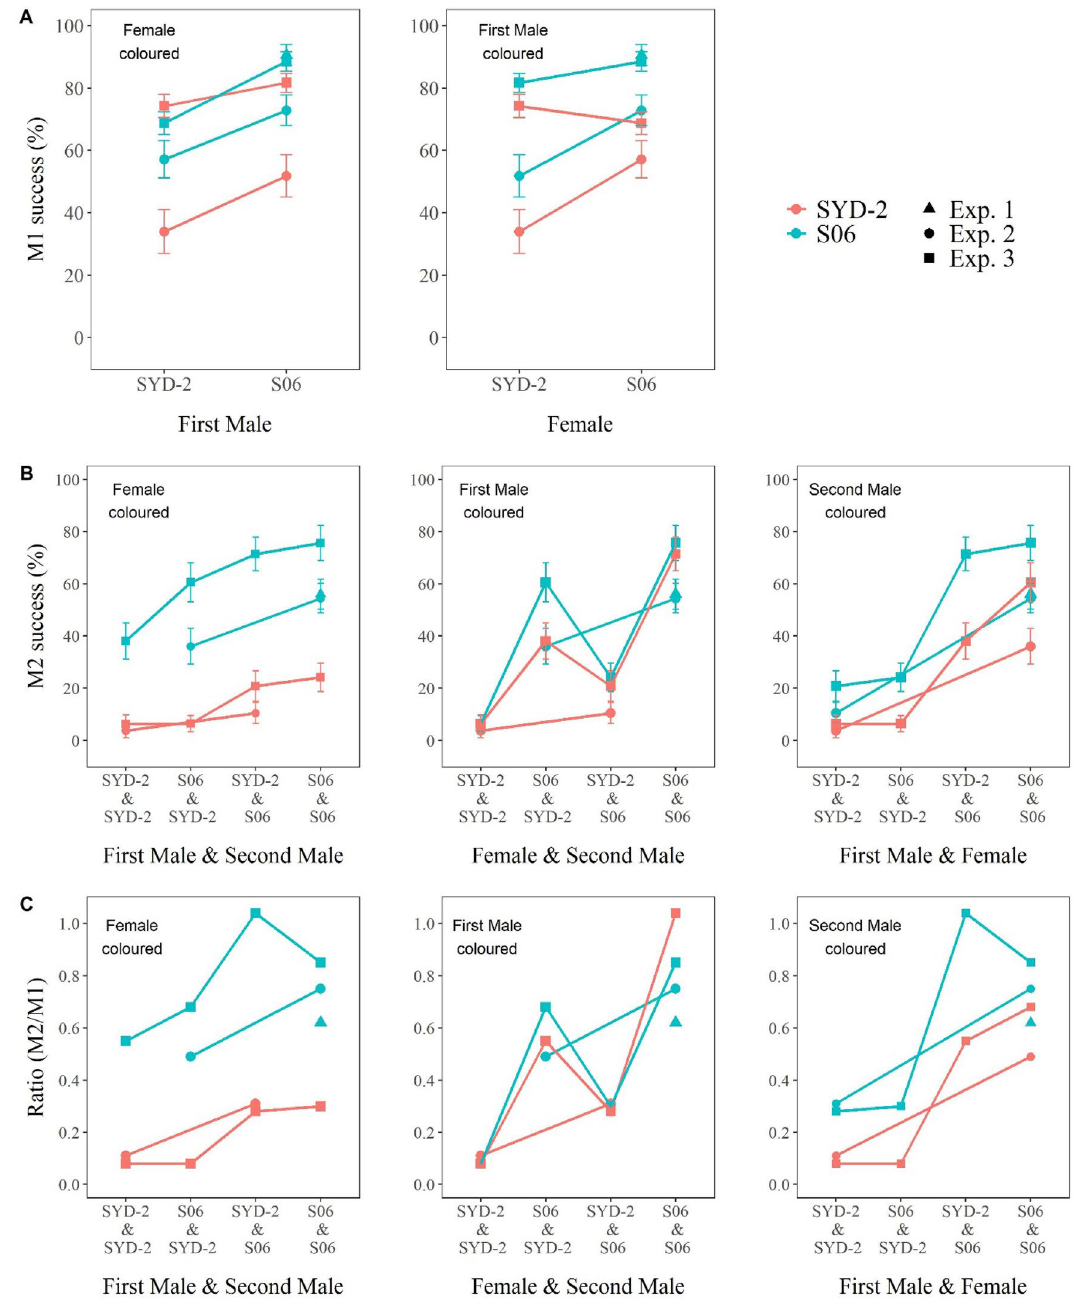
Figure 6. M1%, M2% and M2%/M1% for intra- vs inter-strain pairings, including reciprocals. ( A) M1% ± se for intra- and reciprocal inter-strain pairings of SYD-2 and S06. (B) M2% ± se for females previously mated in all the M1 pairings with M2 males of each strain. (C) M2%/M1% ± se for the females in Panel B. To facilitate visualisation of the effects of each of the different M1 and/or M2 variables, the data for each panel are repeated on two ( A ) or three ( B , C ) separate graphs, one with each of the other variables ( A ) or combinations of variables ( B , C ) on the X axis. Data for the two generations scored have been pooled in all three panels. Where available, results for equivalent pairings and equivalent or adjacent generations from Experiment 1 are also indicated in each panel. Sample sizes for Experiment 3 were 136–160 for M1 and 41–75 for M2. Data from Experiments 1, 2 and 3 are shown as triangles, circles and squares